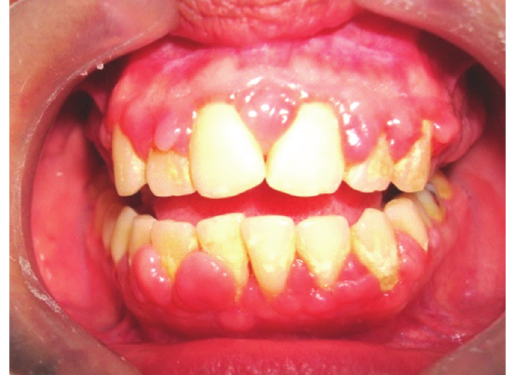
Figure 2: Gingival enlargement can be seen with signs of inflammation in a patient with plaque and calculus (31-year-old female renal transplant patient who was treated with cyclosporin, mycophenolate, and corticosteroids).